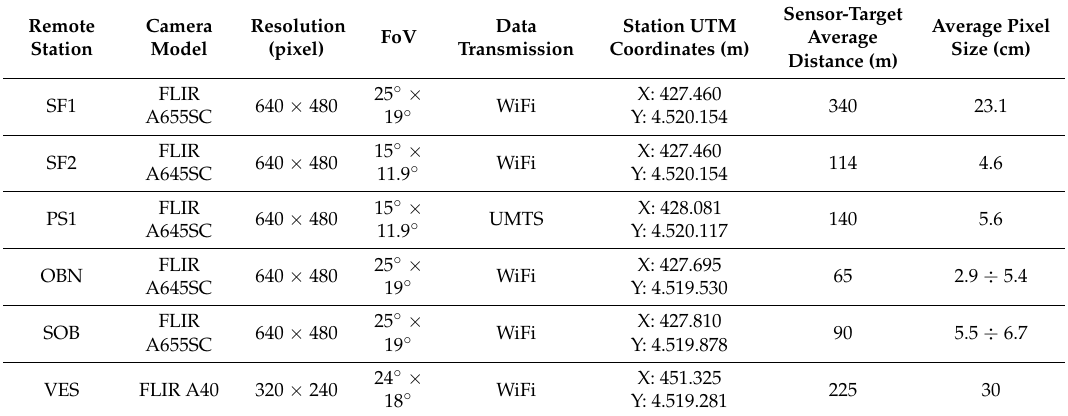
Table 1. Technical specifications of remote stations, FLIR infrared cameras and target areas